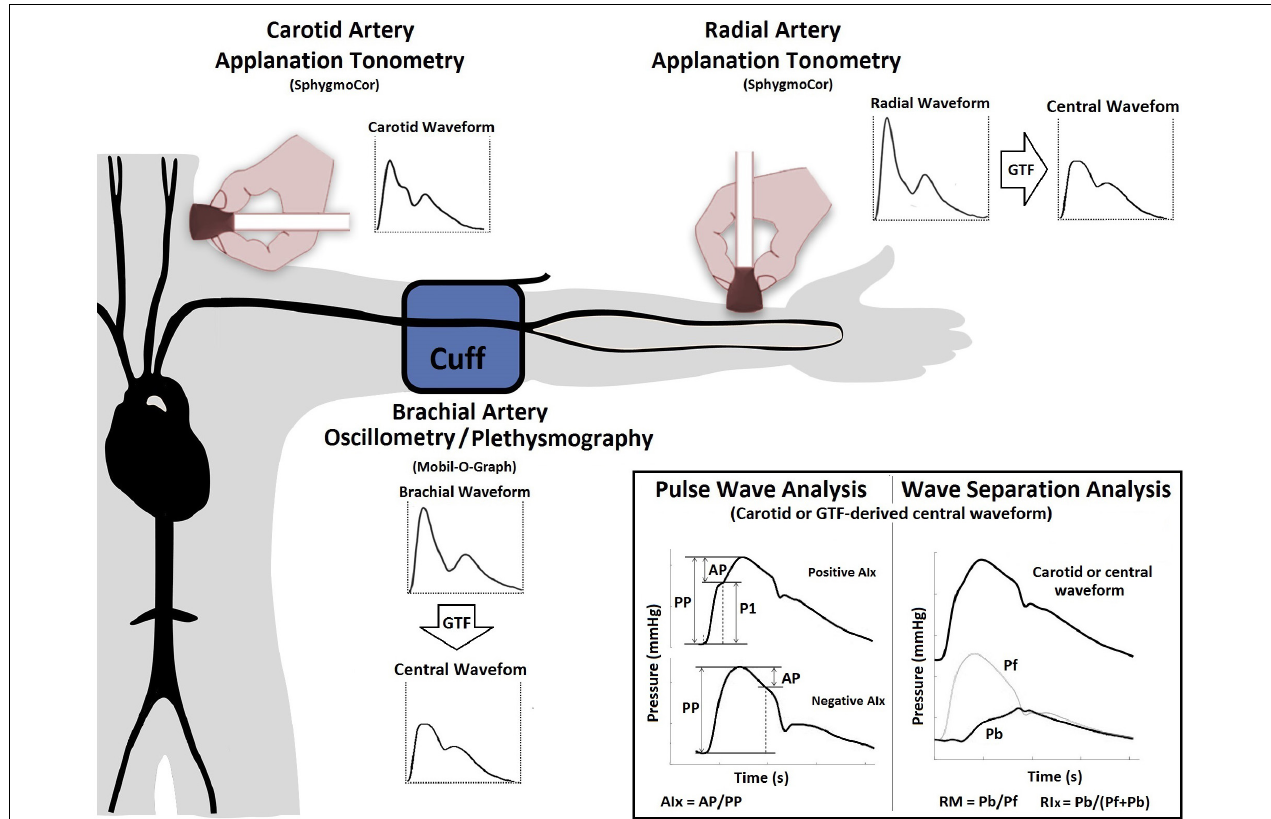
FIGURE 1 | Instrumental approach employed to obtain central blood pressure waves and waveform-derived indexes. Examples of positive and negative AIx. Aix, Augmentation index; AP, augmentation pressure; GTF, general transfer function; Pf and Pb, forward and backward central blood pressure components; PP, pulse pressure; SphygmoCor, SphygmoCor device; v.9, AtCor-Medical, Sydney, NSW, Australia. Mobil-O-Graph, Mobil-O-Graph PWA-monitor system, I.E.M.-GmbH, Stolberg, Germany.